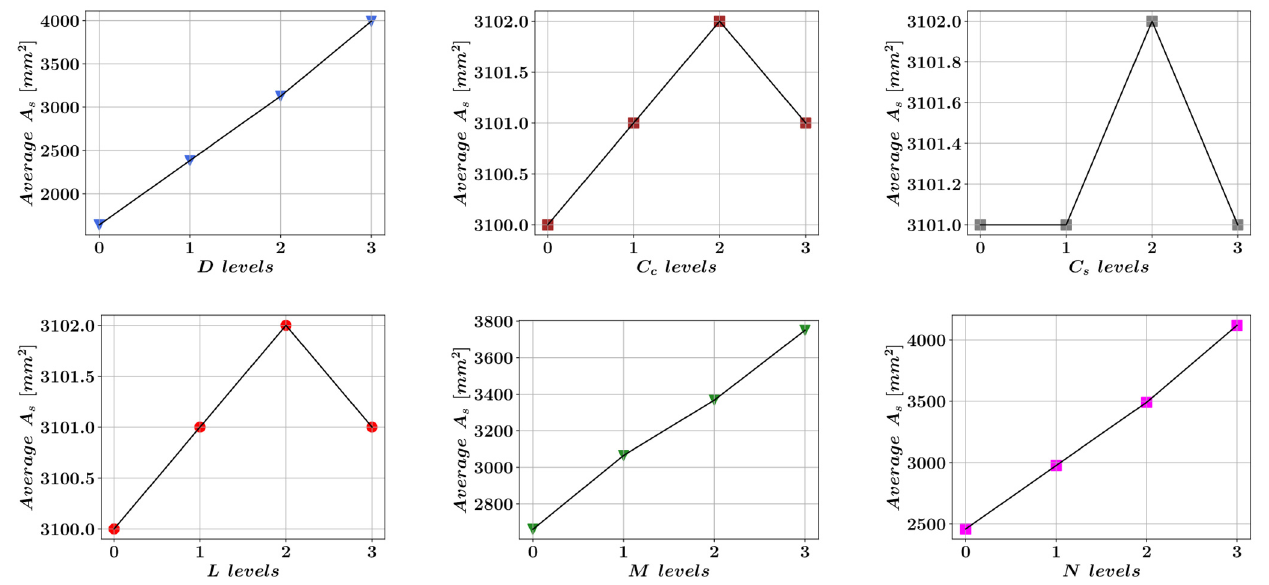
Figure 9. Four-level factorial analysis